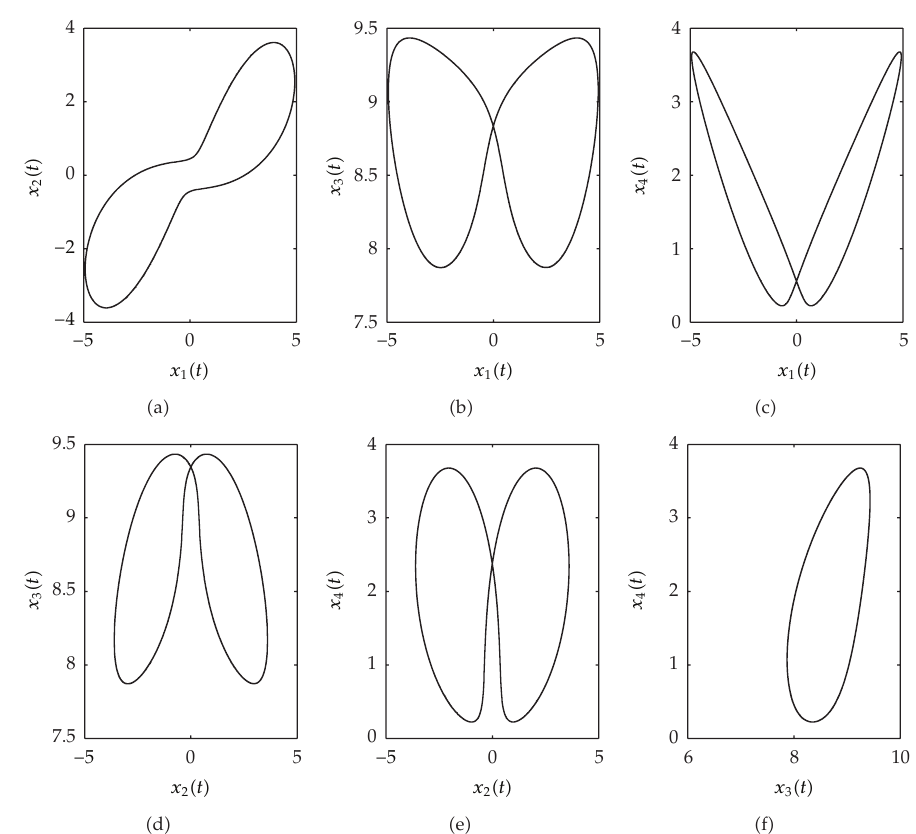
Figure 5: Phase plots for the periodic case of the hyperchaotic Chen system with a (cid:9) 35 , b (cid:9) 10 , c (cid:9) 1 , d (cid:9)